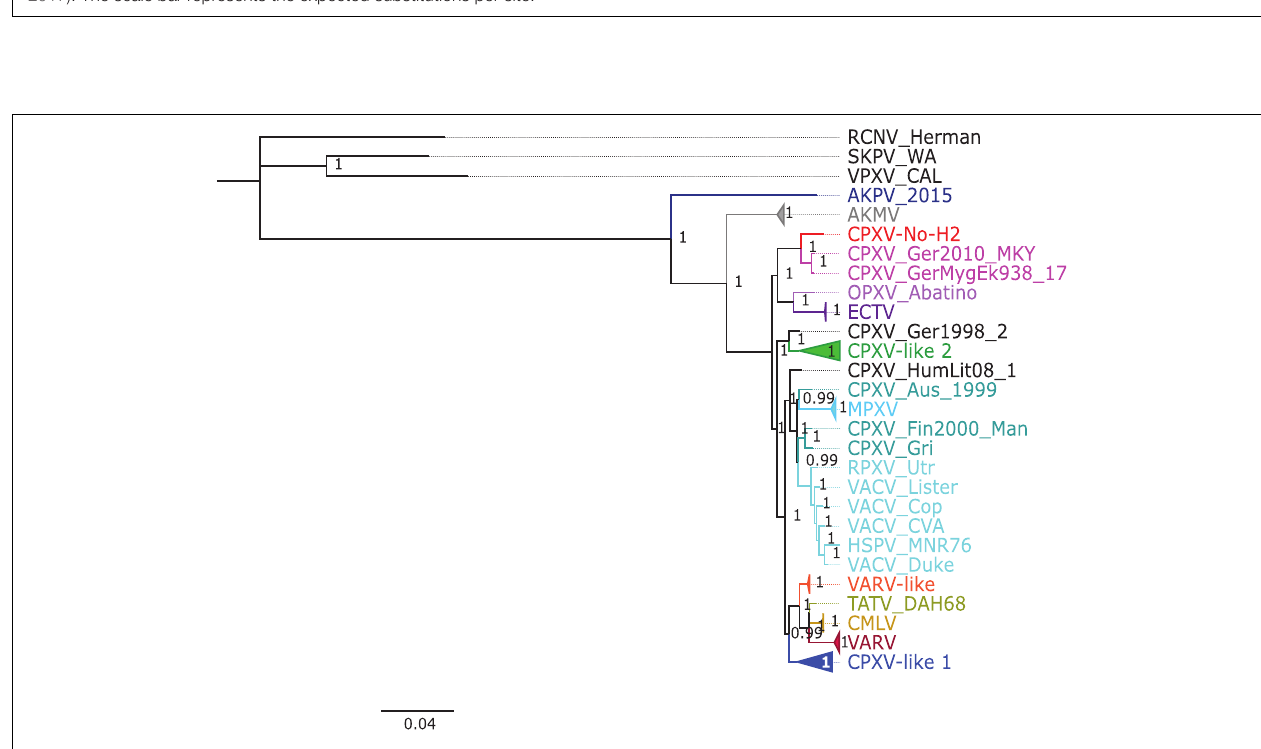
FIGURE 2 | Bayesian inference phylogenetic tree based on 76 orthopoxvirus whole genomes. Posterior probabilities are shown on the right side of each node, and only posterior probabilities above 0.6 are shown. The cowpox virus strains were grouped into different clades: CPXV-like 1, CPXV-like 2, and VARV-like (Franke et al., 2017). The scale bar represents the expected substitutions per site.